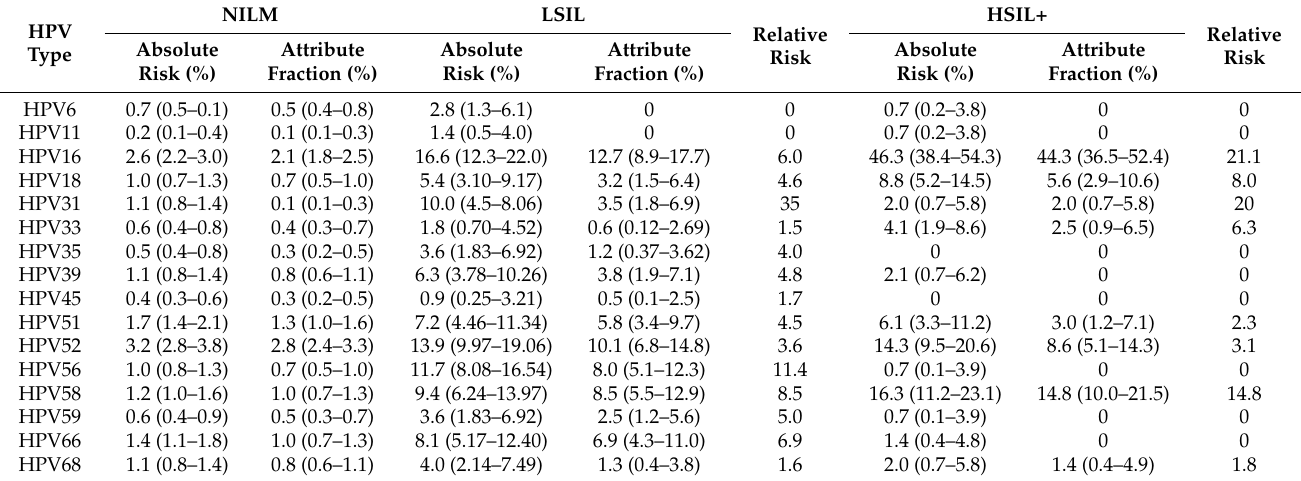
Table 2. The absolute risk and attributable proportion of different HPV types by